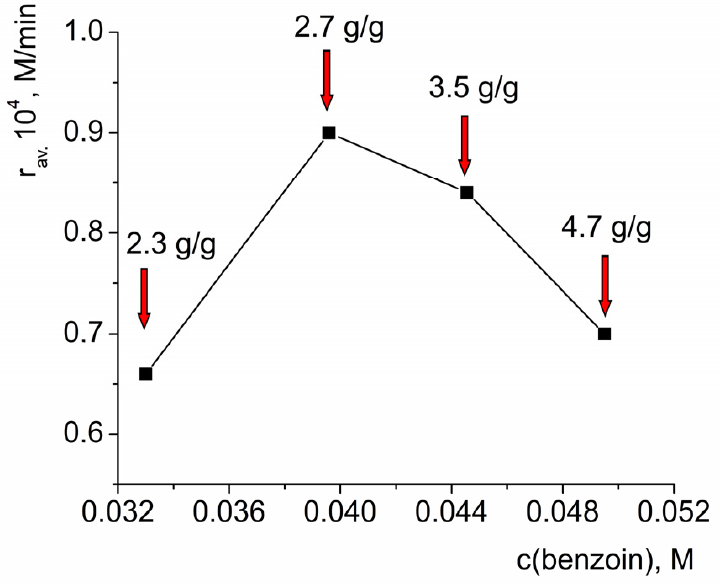
Figure 9. Estimation of the quantity of adsorbed benzoin per 1 g of the catalyst at initial concentration of benzoin vs. average initial oxidation rate. c eff. (HKUST-1) = 0.001 M, c(H 2 O 2 ) = 3.3 M. Solid line in the graph is to guide the eye.